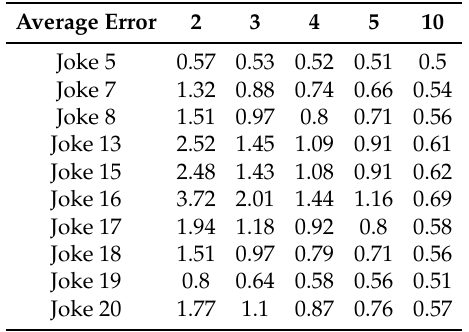
Table 20. Average flooring error for Jester dataset.